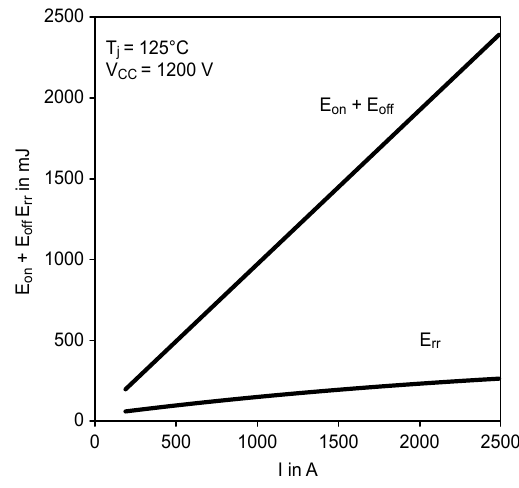
Figure 17: Typical energy losses E = f ( I c , V cc ) [30].